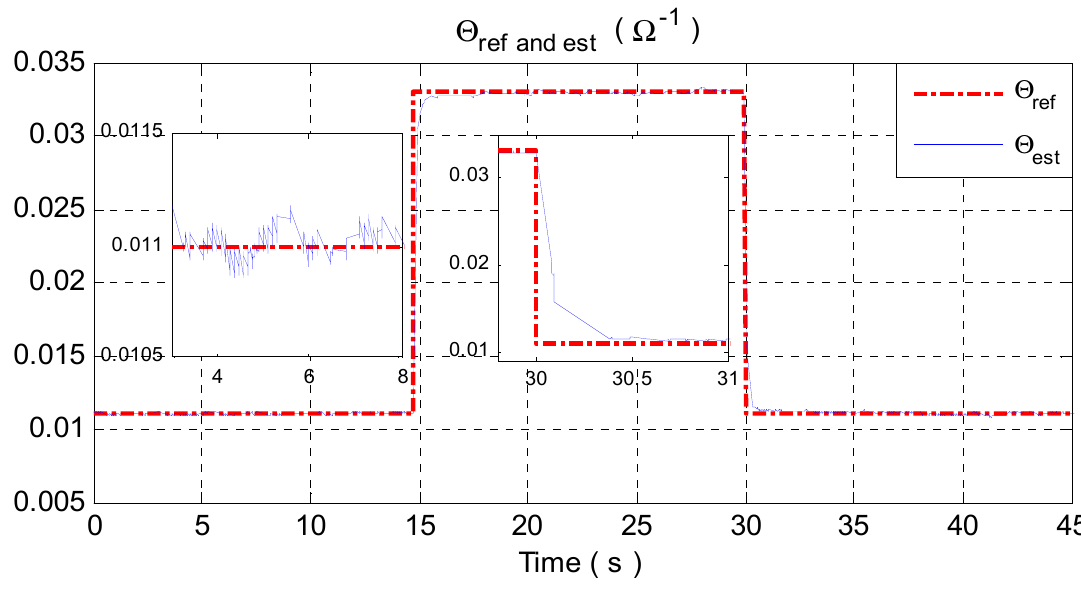
Figure 20. Estimate unknown parameter θ and its reference.